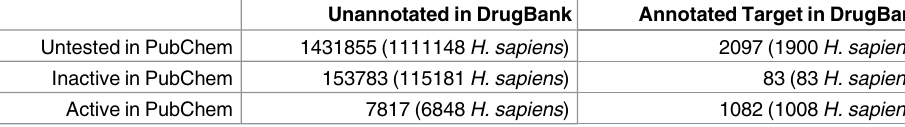
Table 6. Comparison of pubchem bioassay activity data to drugbank target annotations. All com- pound-target pairs for FDA Approved drugs are groupedinto one of six possiblecategories.Dependingon the HTS results in PubChemBioAssay, a compound-target pair is annotated as either untested, inactive, or active (rows in this table). Additionally, the compound-target pair is either annotated or unannotatedas a known active target in DrugBank (columns in this table). Counts outside of parenthesisrepresent results against all protein targets, whereascounts to the right in parenthesis represent results againstthe subset in which the representative UniProt indentiferfor each target cluster is from the H. sapiens